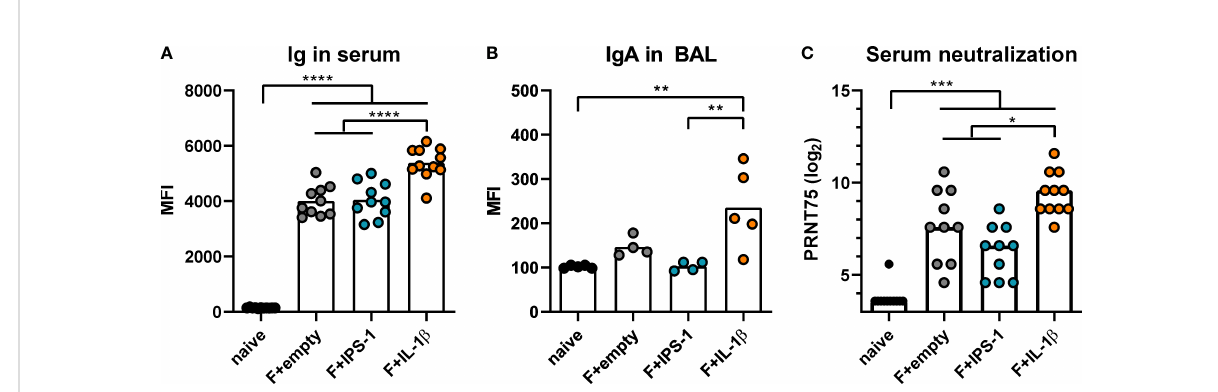
FIGURE 1 Vaccine-induced antibody responses. BALB/cJRj mice were immunized with 2x10 8 particles Ad-F and 1x10 9 particles Ad-empty, Ad-IPS-1, or Ad-IL-1 b . Antibody levels were characterized in sera 35 days and in BAL samples 42 days post-immunization. (A, B) FACS-based analysis for F- speci fi c antibodies was performed for Ig in sera (A , 1:100 dilution, detection with anti-Ig-FITC ) and for IgA in BAL samples (B , 1:20 dilution, detection with anti-IgA-FITC ) with HEK 293A cells expressing the F protein. Shown are the MFIs for each sample and the mean of the values for each group. (C) 75% plaque reduction neutralization titers (PRNT75) were analyzed in sera by RSV microneutralization assay (detection limit at a titer of <1:12). Bars represent group means (A, B) or medians (C) overlaid with individual data points. n=10-11 for sera and n=4-5 for BALs. Data were analyzed by one-way ANOVA followed by Tukey´s post test (values in C were log-transformed before analysis). * p <0.05, ** p <0.005, *** p <0.0005, **** p